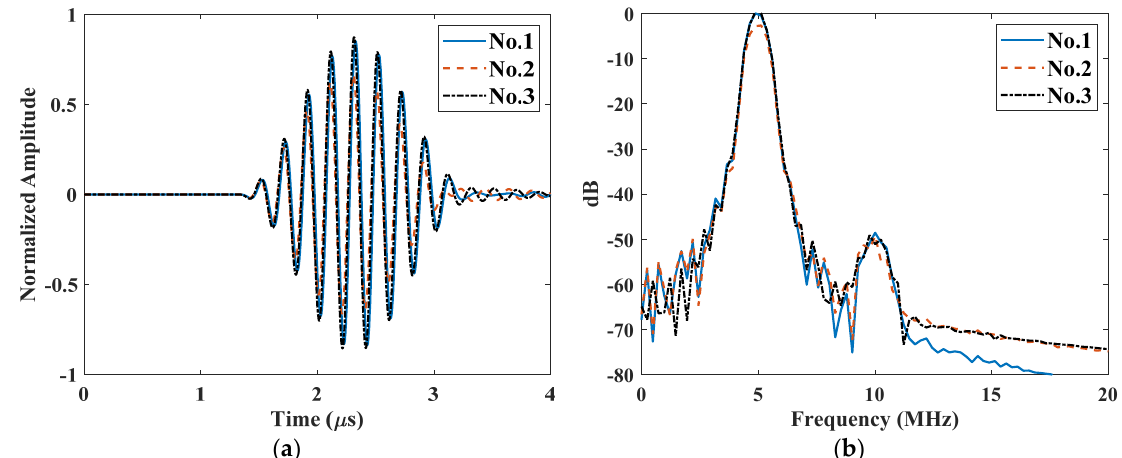
Figure 8. Three typical signals from the through-transmission model for the same rough surface ( R q = 50 µ m): ( a ) A-scan waveforms and ( b ) their spectra.